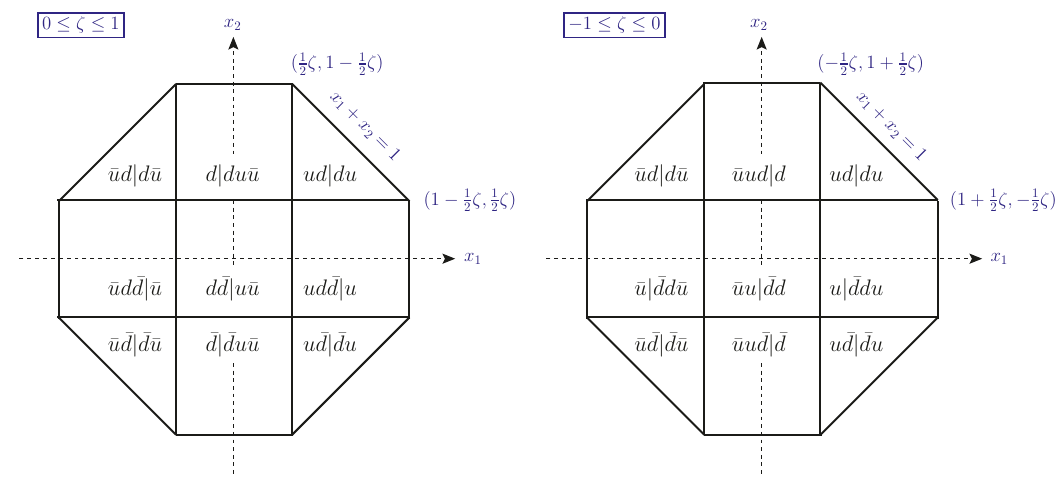
(cid:0) 1 (cid:1) | ζ | , 1 | ζ | , 2 2